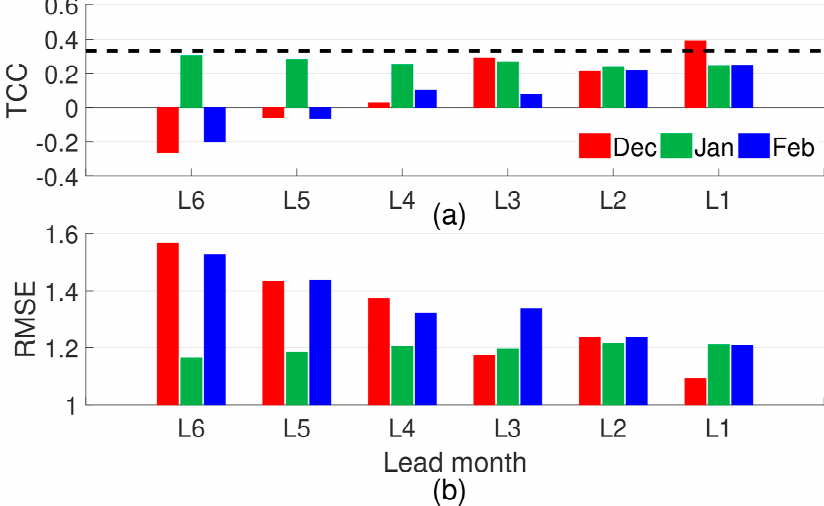
Figure 2. The prediction skill (time correlation coefficient (TCC , a ) and root-mean-square error (RMSE, b ) of the North Atlantic Oscillation (NAO) in December (red bars), January (green bars), and February (blue bars) predicted by the Climate Forecast System, version 2 (CFSv2) at different lead times (months).